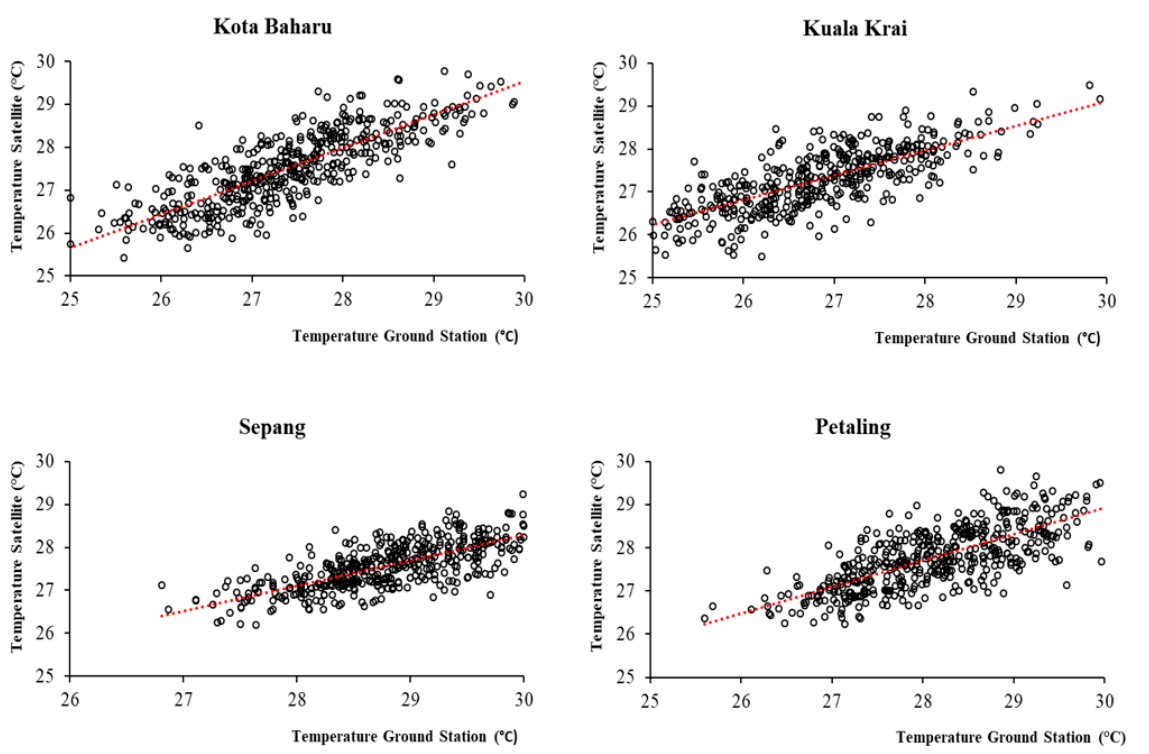
Figure 4 . Correlation between temperature data from EO and the four ground-based stations, 2011 to 2019, Malaysia.